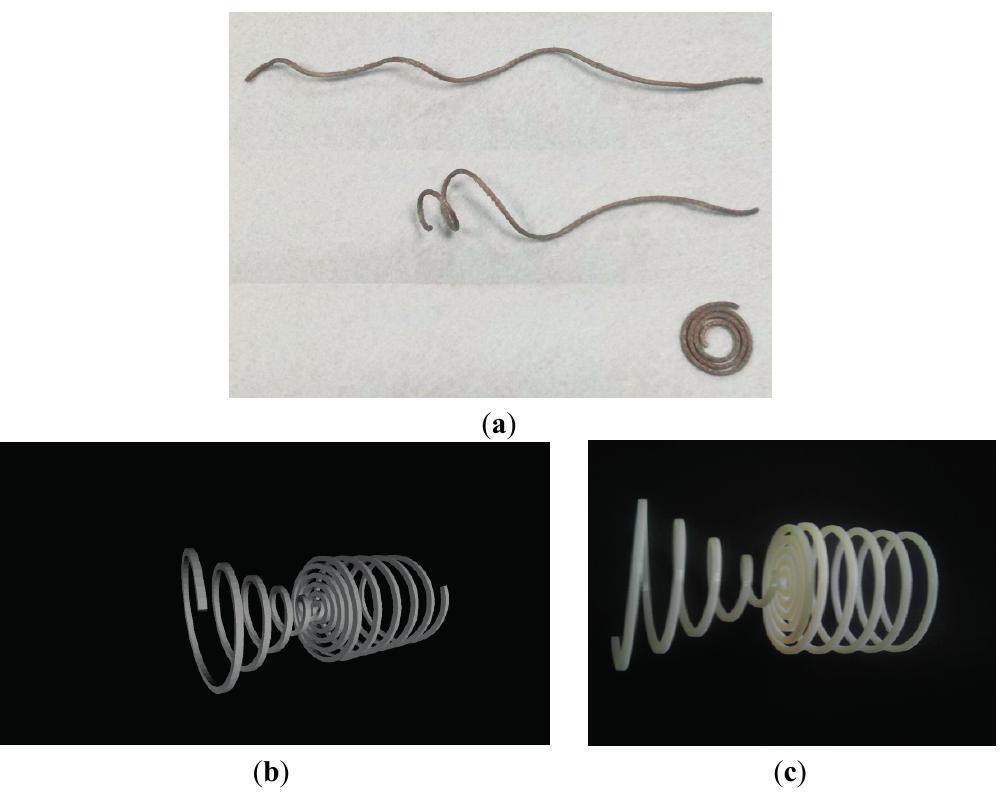
Figure 13. 3D printed springs for temporary endovascular embolization in interventional radiology. ( a ) Straightened shape (top) and then heated for shape recovery (middle to bottom); ( b , c ) a more complicated version. ( b ) 3D view of concept; ( c ) 3D printed